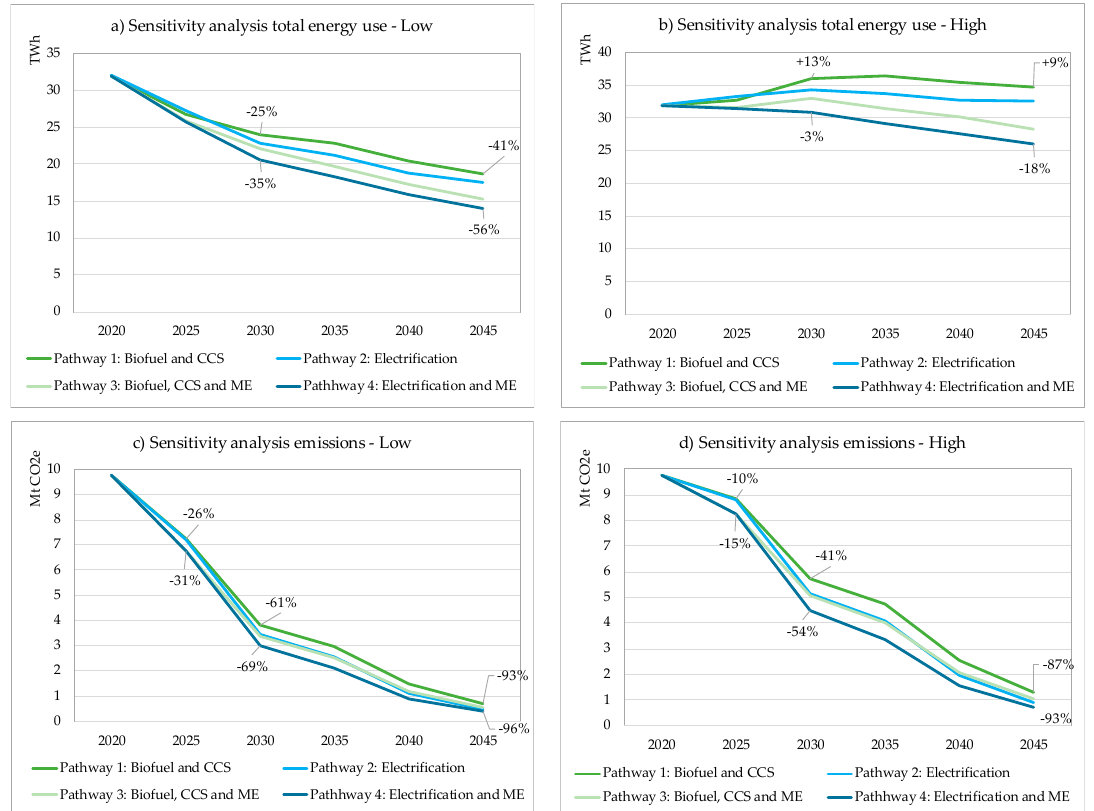
Figure 9. Sensitivity analysis based on reduced or increased construction demand for the different pathways with (a),(b) depicting the impact on total energy demand, and (c),(d) depicting the impact on emissions, for low and high construction demand, respectively.